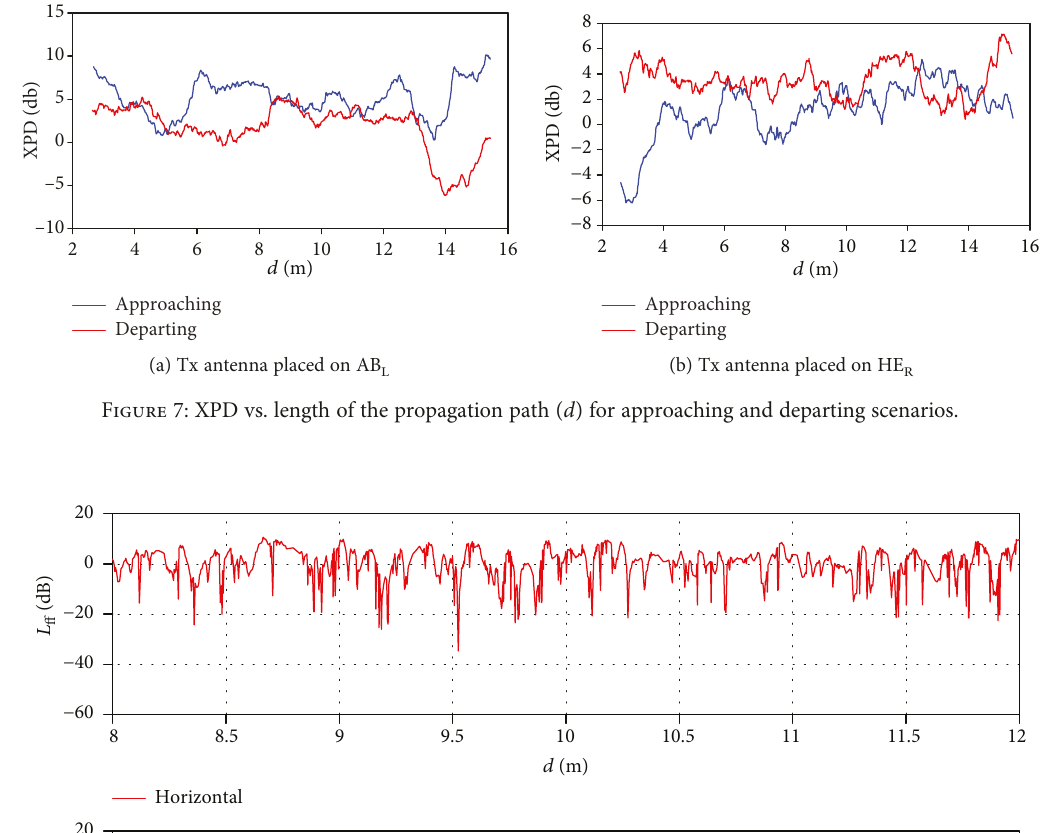
) vs. sample length of the propagation path ( d ) for departing scenario and Tx antenna placed on TO ff